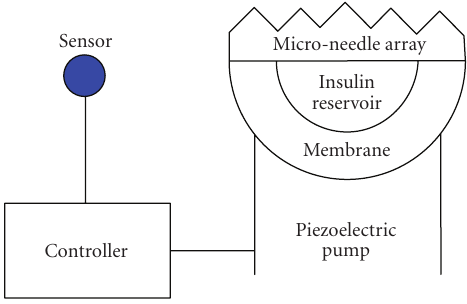
Figure 4: Piezoelectric pump and micro-needle